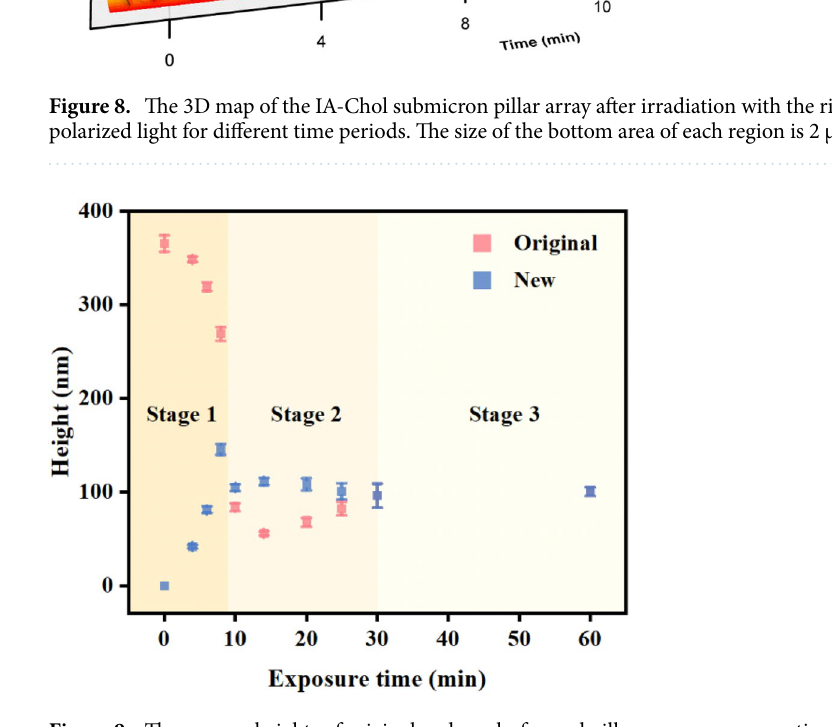
Figure 9. The average heights of original and newly-formed pillars versus exposure time. In the stage 1, the original pillars are higher than the newly-formed pillars. In the stage 2, the original pillars are lower than the newly-formed pillars. In the stage 3, the heights of original and newly-formed pillars are the